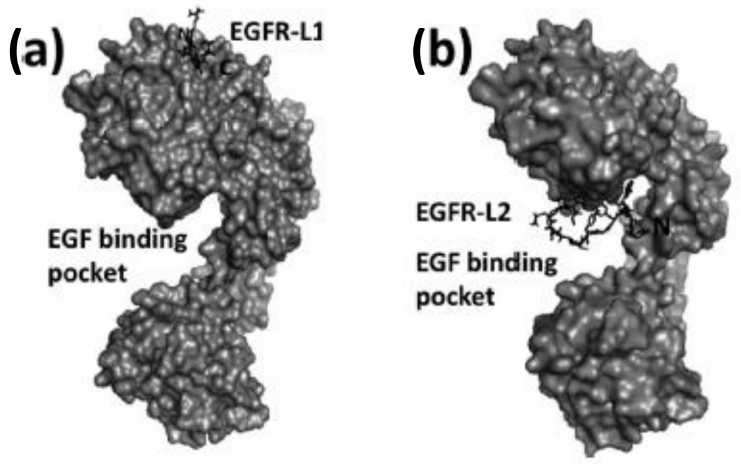
Figure 7. Structures of peptide ligands on their binding sites: ( a ) EGFR-L1 in domain I, and ( b ) EGFR- L2 in the EGF binding pocket (PDB ID: 1NQL) proposed based on docking studies. Peptides are shown as sticks, and EGFR is shown in surface representation. This figure was reprinted with permission from Reference